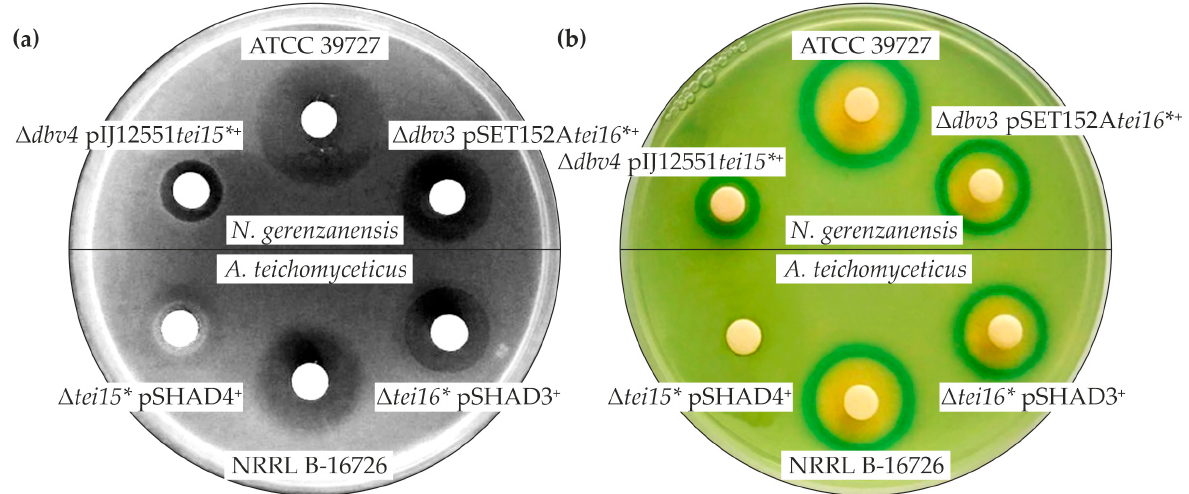
Figure 3. GPA production phenotypes of N. gerenzanensis and A. teichomyceticus CSRGs mutants complemented with heterologous CSRGs tested by B. subtilis HB0933 ( a ) and HB0950 ( b ) growth inhibition assays. N . gerenzanensis Δ dbv4 pIJ12551 tei15* + , Δ dbv3 pSET152A tei16* + , and A. teichomycet- icus Δ tei16* pSHAD3 + inhibited the growth of B. subtilis HB0933 and induced X-Gal chromogenic